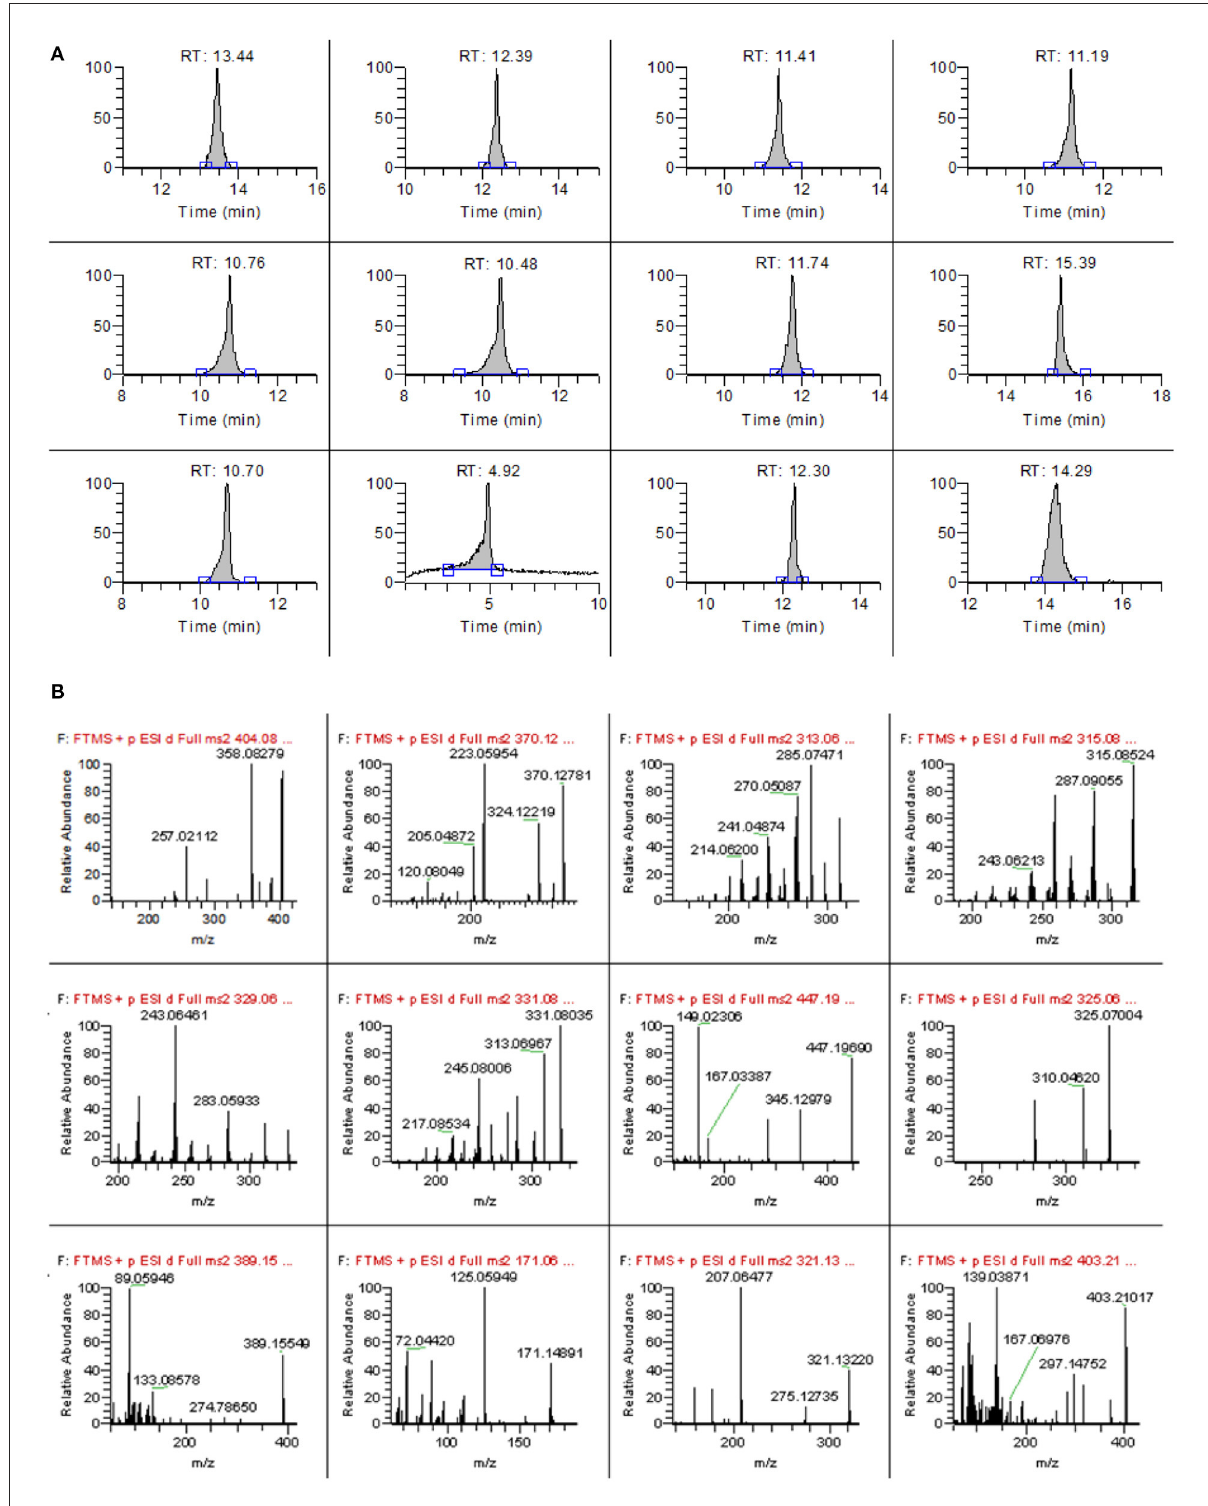
FIGURE1 The chromatograms (A) and high-resolution mass spectrum (B) of 12 mycotoxins.